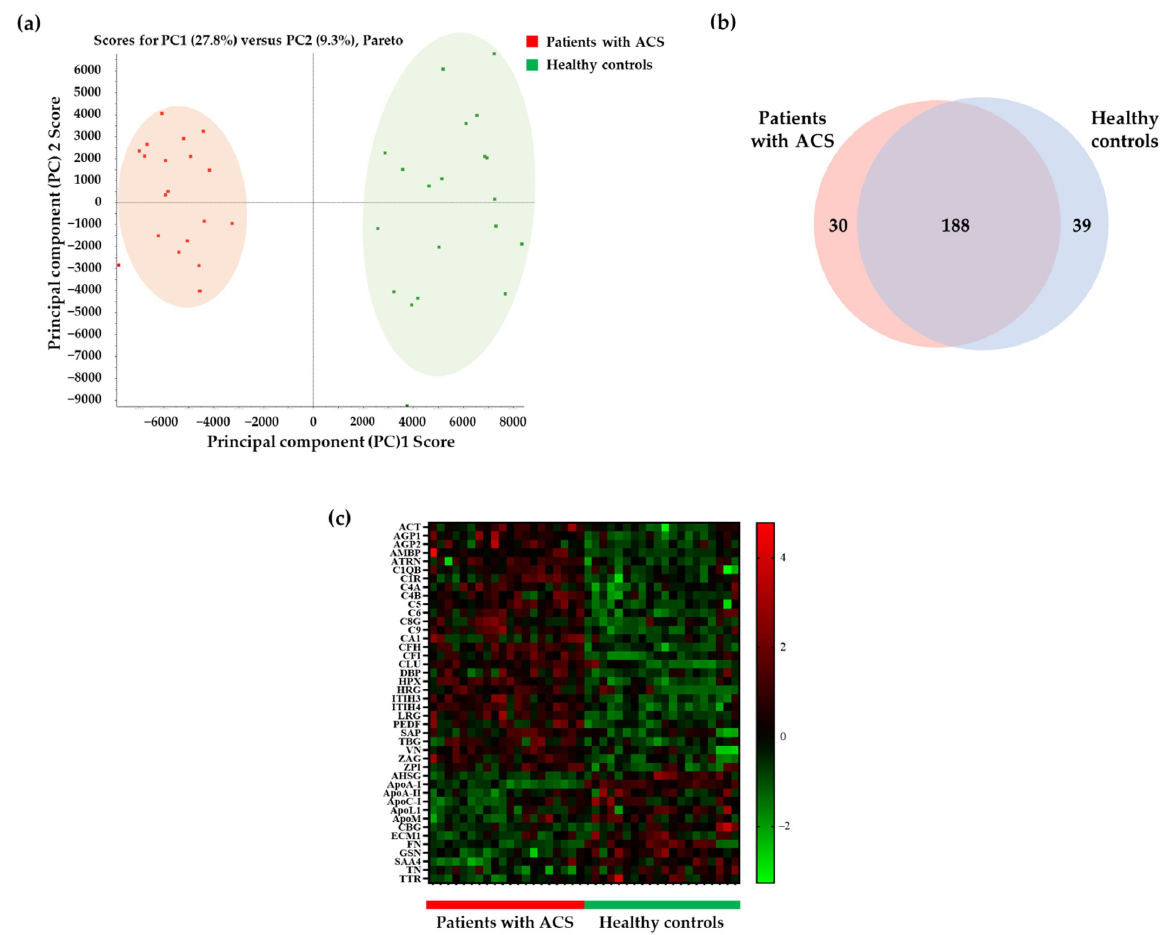
Figure 2. Selection of differentially expressed proteins between patients with ACS and healthy controls. ( a ) The principal component analysis (PCA) score plot shows the separation of samples of patients with ACS and healthy controls. ( b ) The Venn diagram shows confirmed commonly expressed proteins between patients with ACS and healthy controls. The number of proteins identified in patients with ACS and healthy controls were 218 and 227, respectively, with the number of proteins identified in both groups being 188. ( c ) Of the 188 proteins, proteins with p -value < 0.05 and a fold change of 1.2 or more or 1/1.2 or less were selected using the t -test. We selected 42 proteins exhibiting significant intensity of peak and false discovery rate (FDR) in the heat map. ACT, α -1-antichymotrypsin; AGP1, α -1-acid glycoprotein 1; AGP2, α -1-acid glycoprotein 2; AMBP, protein AMBP; ATRN, attractin; C1QB, complement C1q subcomponent subunit B;